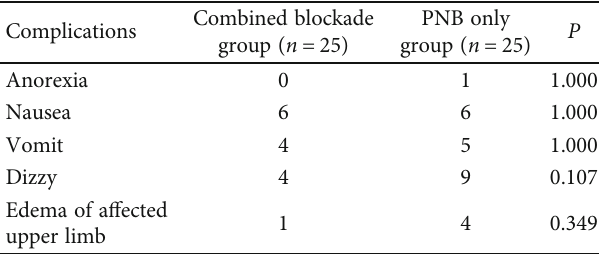
Table 3: Incidence of complications during the fi rst two postoperative